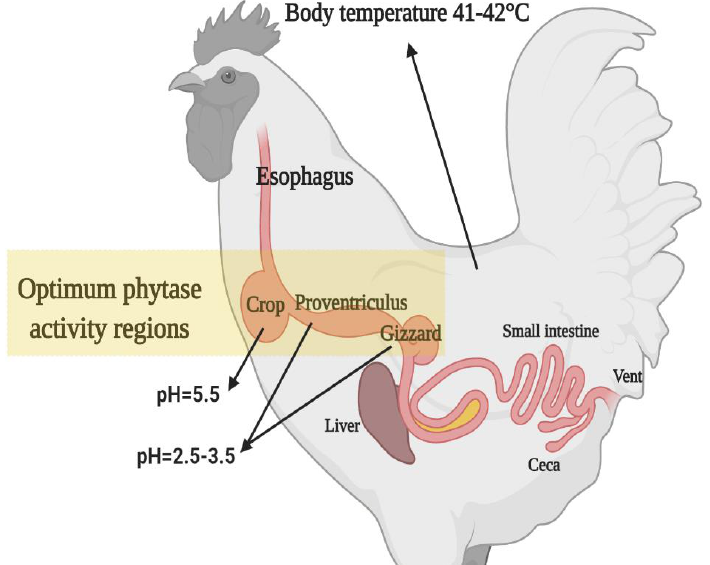
Figure4. PhytaseactivityregionswiththeirpHrangesarehighlightedwithyellowcolor. Bodytemperature of chicken for optimum phytase activity is shown at upper part of